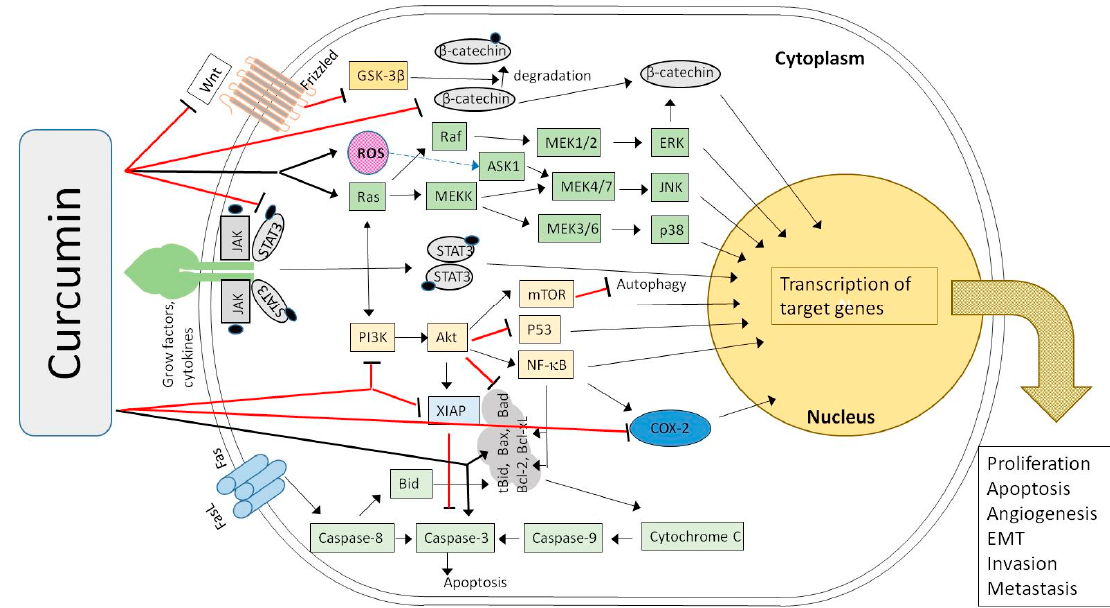
Figure 5. Model of the regulation and control of the cellular signal transduction involved in the process of carcinogenesis in the presence of curcumin ( → activation, ⊥ inhibition) (based on [39,47,55–58,60,63,73–75]).